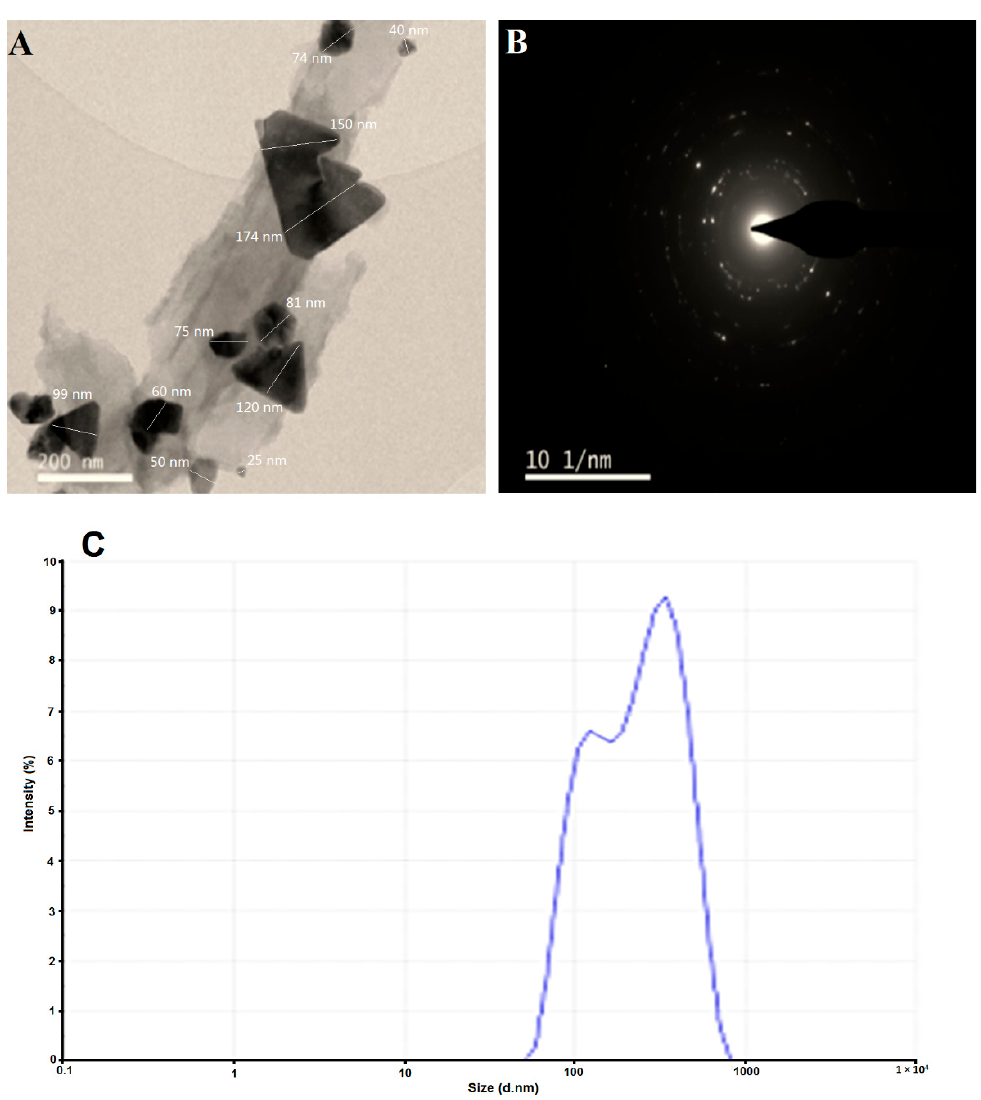
Figure 5. TEM image ( A ), SAED pattern ( B ), and DLS ( C ) of the synthesized Ag/Fe 2 O 3 by Buddleja lindleyana extract.